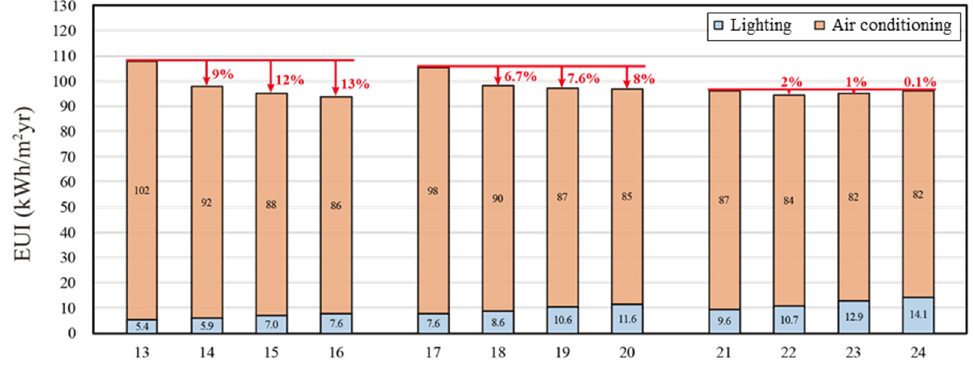
Figure 18. Energy simulation analysis of cases with WWR = 50%.